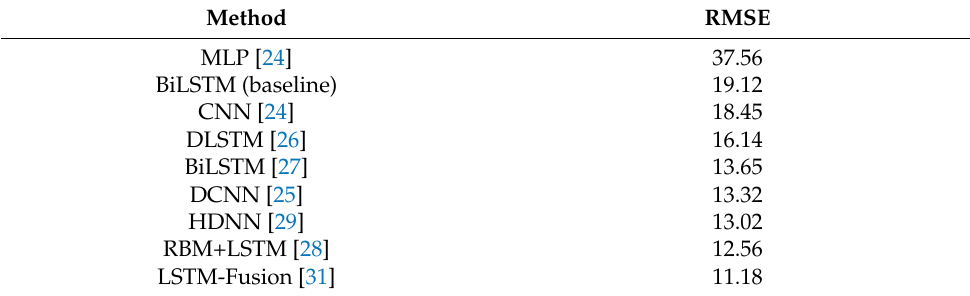
Table 3. Comparison of method performance on a dataset C-MAPSS (FD001).